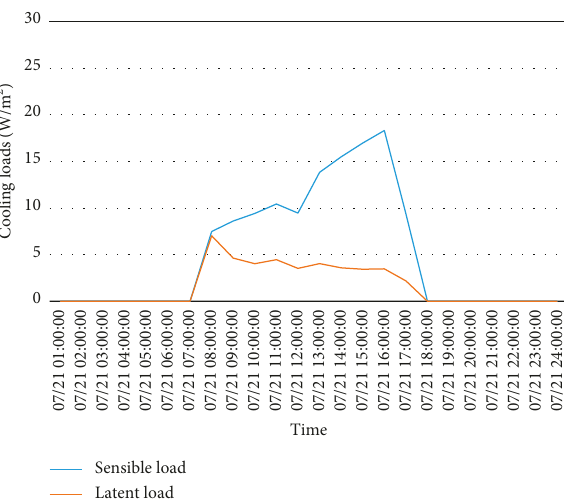
Figure 8: Sensible load and latent load on a peak day.